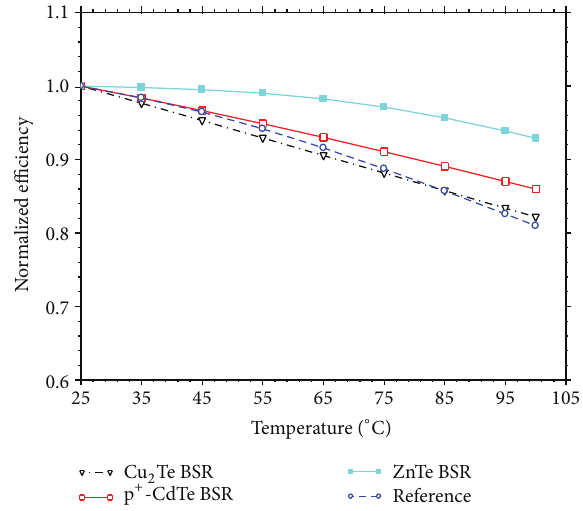
Figure 8: Effect of operating temperature on normalized efficiency of reference and modified cell